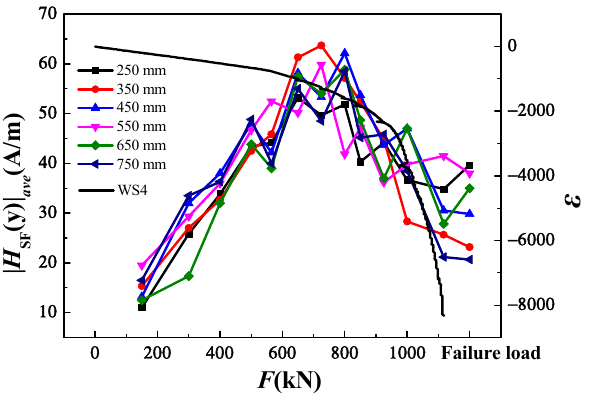
Figure 17. |𝐻 (cid:2903)(cid:2890) (y)| (cid:3028)(cid:3049)(cid:3032) - F relationship curves. Figure 17. | H SF ( y ) | - F relationship ave From Figure 17, the |𝐻 (cid:2903)(cid:2890) (y)| (cid:3028)(cid:3049)(cid:2915) value increased with the load increasing in the elas- tic loading stage; when loaded to 650 kN, the curves showed a maximum value, and the strain corresponding to this load was approximately the yield strain. Subsequently, the |𝐻 (y)| (cid:2903)(cid:2890) (cid:3028)(cid:3049)(cid:2915) value showed a decreasing trend of fluctuation with the load increasing, and